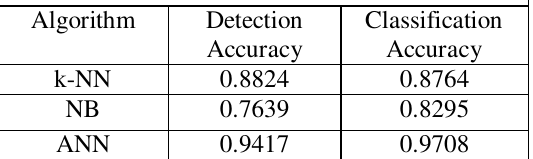
Table 5: Comparison of ANN with ML algorithms